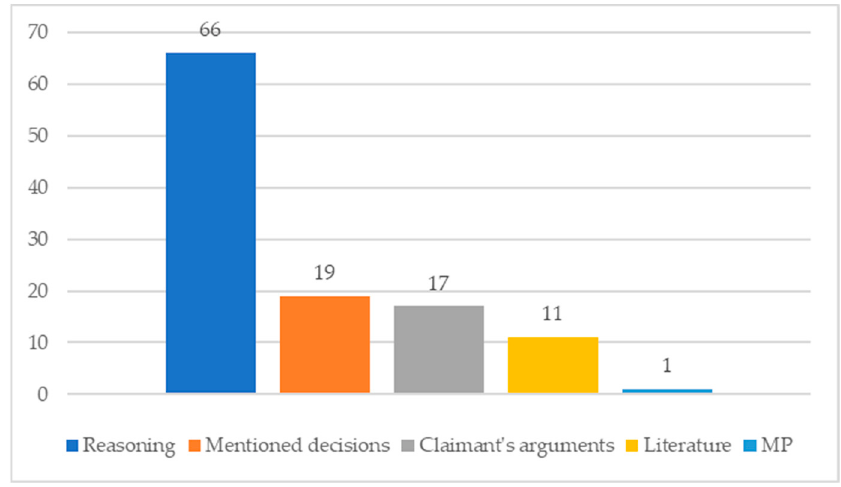
Figure 3. Where in the decision the expression